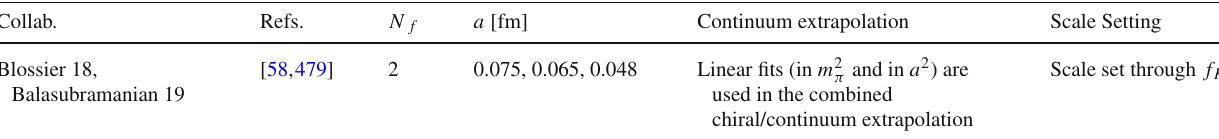
Table 130 Lattice spacings and description of actions used in N f = 2 determinations of the D - and D s -meson decay constants Collab.